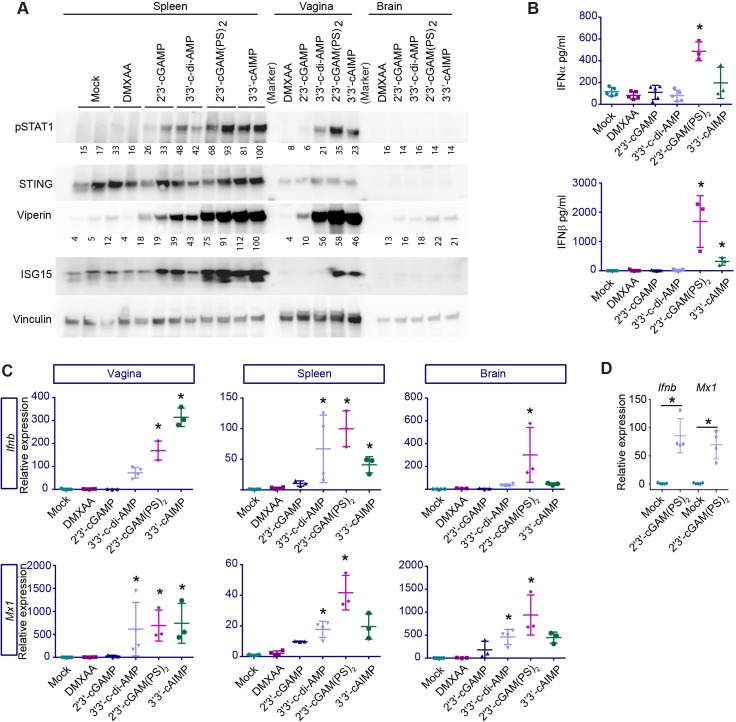
STING agonists induces type I IFN expressing in vivo.Equimolar (1.687x10-7 mol) doses of STING agonists 2’3’-cGAMP (121 μg/mouse), 3’3’c-diAMP (119 μg/mouse), 2’3’-cGAM(PS)2 (125 μg/mouse), 3’3’-cAIMP (111 μg/mouse) or DMXAA (95 μg/mouse, STING activation by DMXAA requires two molecules (3.374x10-7 mol)) were administrated to mice i.p. Samples were collected 6 hours later for further analysis. (A) Levels of phosphorylated STAT1 (pSTAT1), STING, viperin and ISG15 were determined by Western blotting of spleen, vagina and brain tissues. Vinculin was used as loading control. n = 5, two representative samples are shown. (B) IFNα and IFNβ in the serum determined by ELISA. n = 3–5. * = p<0.05 compared to mock. (C) Expression for Ifnb and Mx1 mRNA in tissues samples from vagina, spleen and brain, normalized to GAPDH. n = 3–5. * = p<0,05 compared to mock. (D) Mice were perfused prior to isolation of brain samples and gene expressions of Ifnb and Mx1 mRNA were measured. n = 3–5. * = p<0,05 compared to mock. Statistics, (B-D) Kruskal-Wallis test with Dunn’s multiple comparisons test.